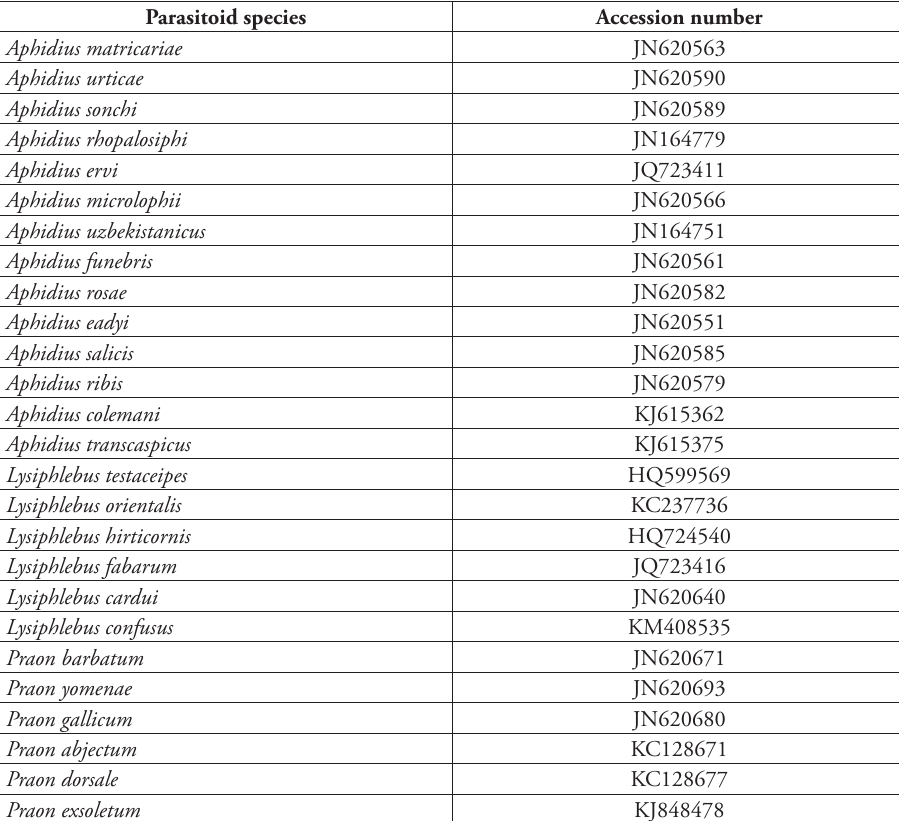
Table 2. The list of reference Aphidiinae species obtained from GenBank and used in designing the genus-specific